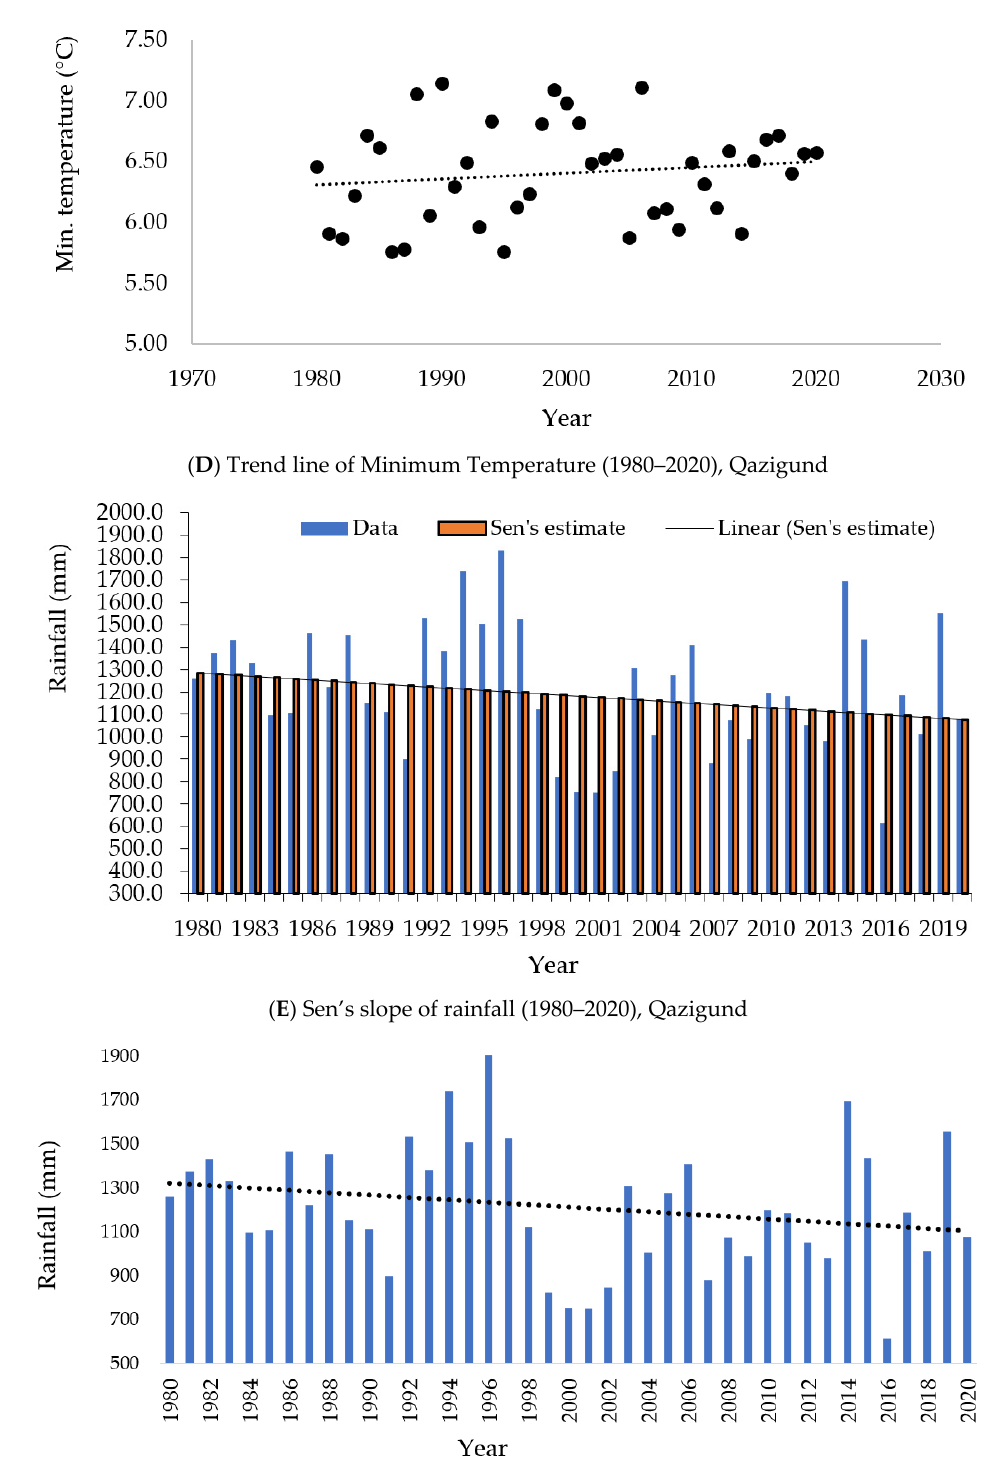
Figure 3. Descriptive statistics of weather parameters viz., Maximum and Minimum Temperature and Rainfall of location Qazigund